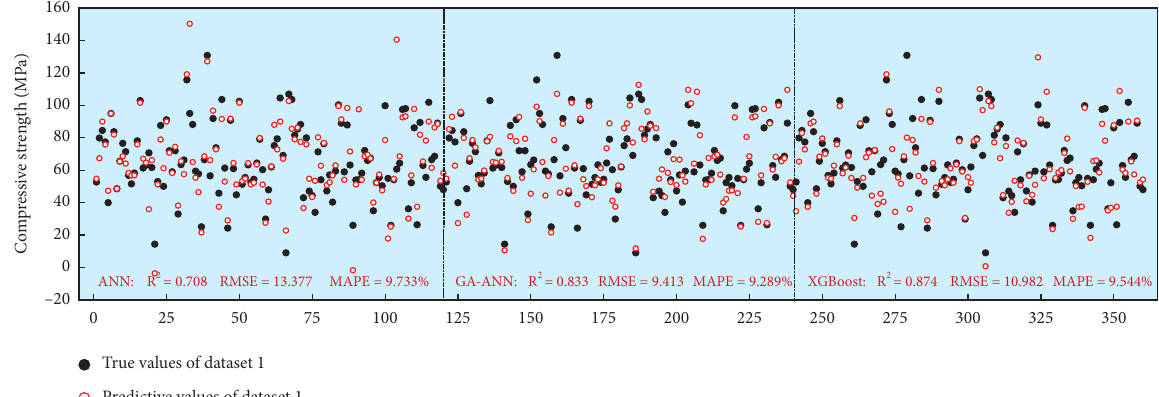
Figure 11: Predictive and true values of ANN, GA-ANN, and XGBoost for dataset 1.